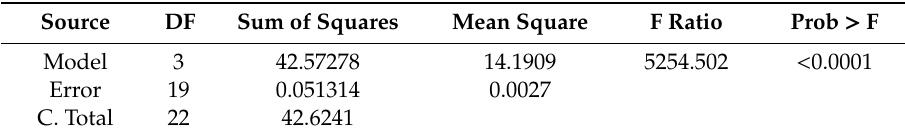
Table 6. Analysis of variance parameter Ra .